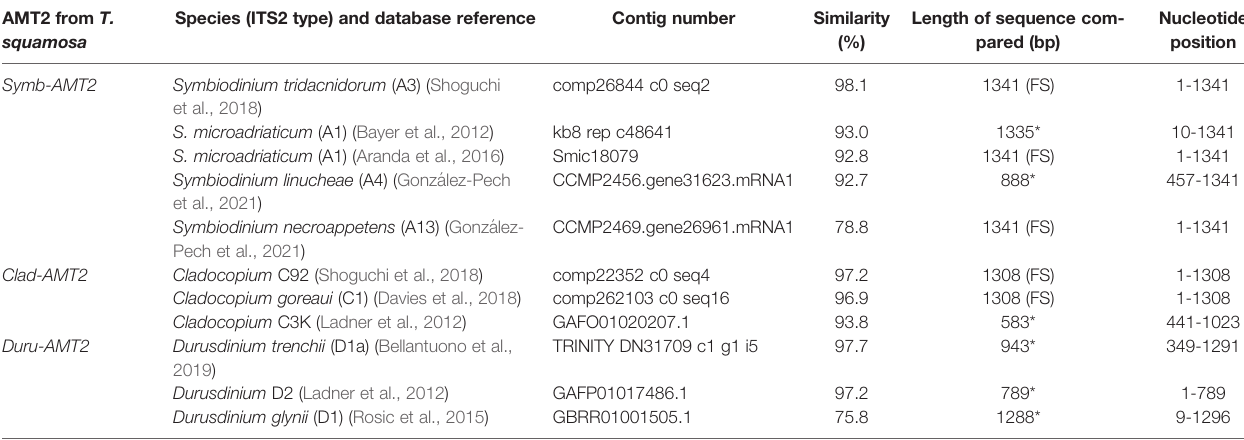
TABLE 1 | A comparison of the nucleotide sequences of ammonium transporter 2 ( AMT2 ) derived from Symbiodinium ( Symb-AMT2 ), Cladocopium ( Clad-AMT2 ) and Durusdinium ( Duru-AMT2 ) of Tridacna squamosa with selected AMT2 contigs obtained from various dino fl agellate databases. AMT2 from T.